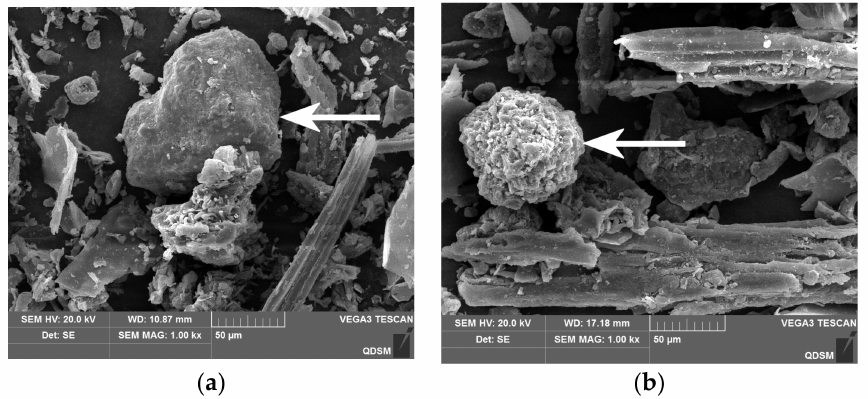
Figure 2. SEM images of ( a ) AC and ( b )